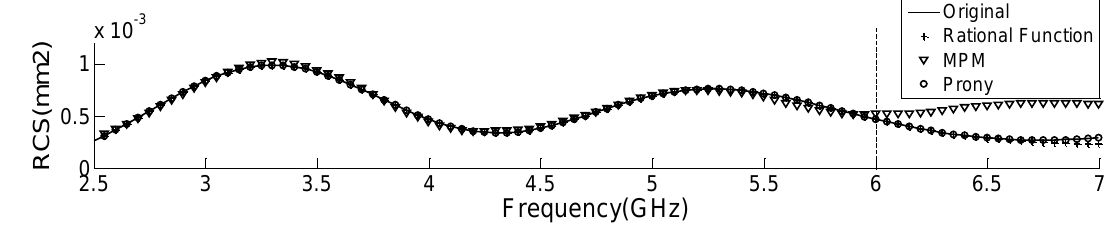
Figure 6. Transport Plane RCS prediction errors at 18 deg. Figure 7. F-117 RCS prediction results at 153 deg.